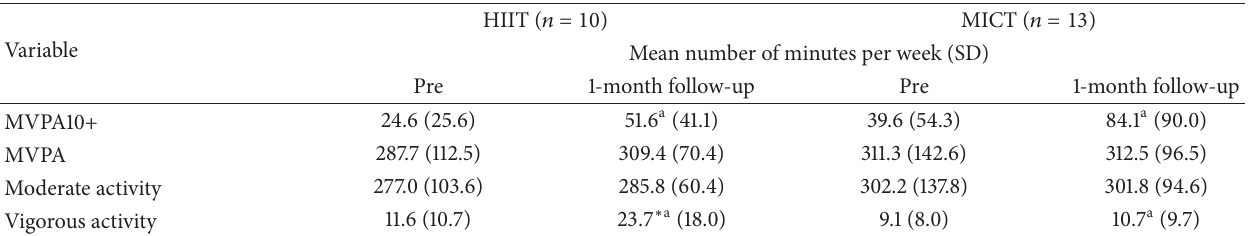
Table 2: Mean values for physical activity behaviour before the intervention (pre) and at one-month follow-up (post) for HIIT and MICT, as measured by